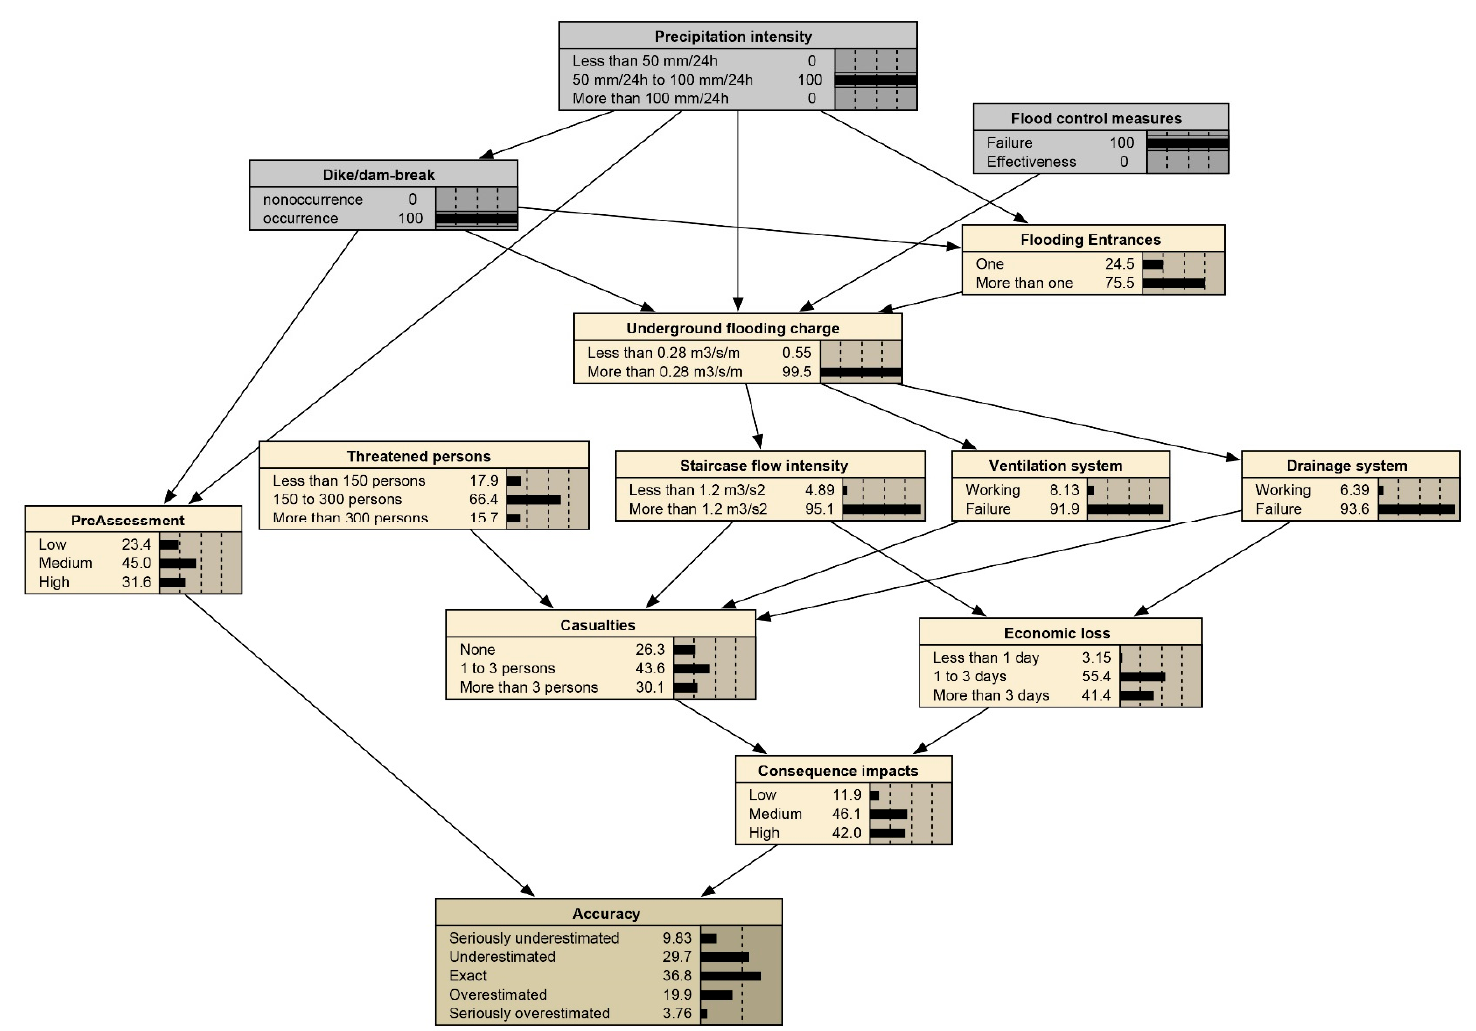
Figure 7. Inference results with pre-assessment (dike/dam break).